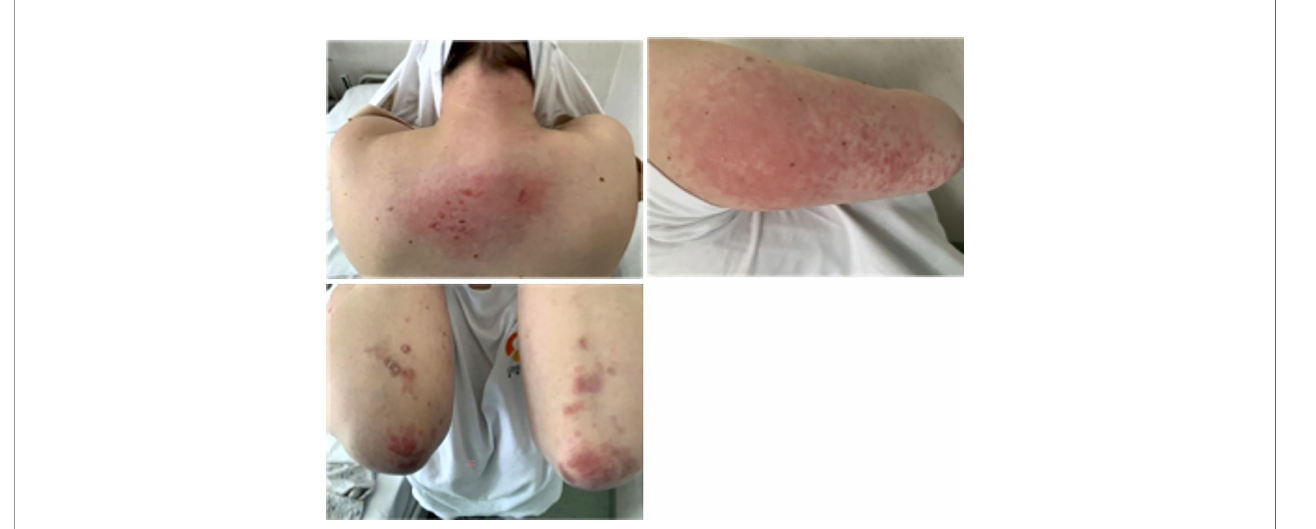
FIGURE 2 | Dermatomyositis-like clinical presentation closely correlated with anti-SARS-2 vaccination. The fi gure shows a representative case of a dermatomyositis- like clinical presentation in a patient after SARS-COV2 vaccination.